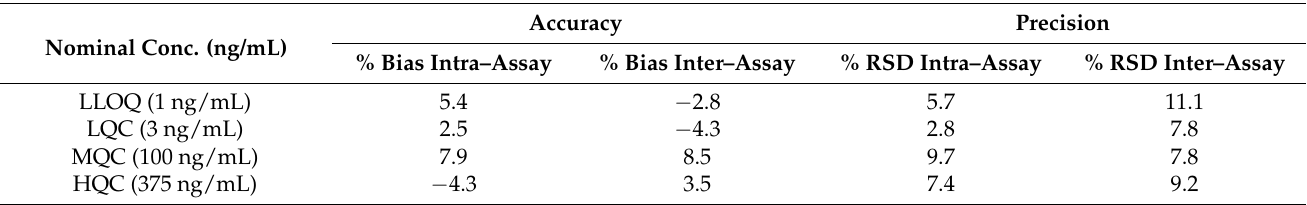
Table 3. Indole accuracy and precision. Intra-assay and inter-assay accuracy and precision of indole in mouse plasma (n = 5).